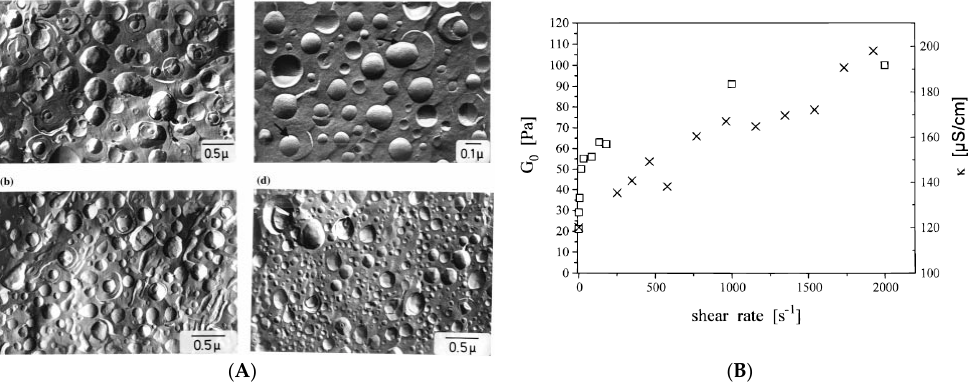
Figure 5. ( A ): FF-TEM micrographs of the system 90 mM TDMAO/10 mM TTABr/220 mM 1-hexanol: ( a ) immediately after shearing the sample for 1.5 h at a shear rate of 200 s − 1 ; ( b ) 2000 s − 1 ; ( c ) 4000 s − 1 ; ( d ) after allowing the system depicted in ( c ) to relax under stirring for 12 days; ( B ): Shear modulus G 0 ( □ ) and electric conductivity during shear in vorticity direction (×) versus shear rate of the pre-shear for the same system. The vesicle solution was sheared at the given shear rate until the apparent shear viscosity indicated a steady state. Then, shearing was stopped and the modulus was measured in an oscillation experiment (Original in [51]).